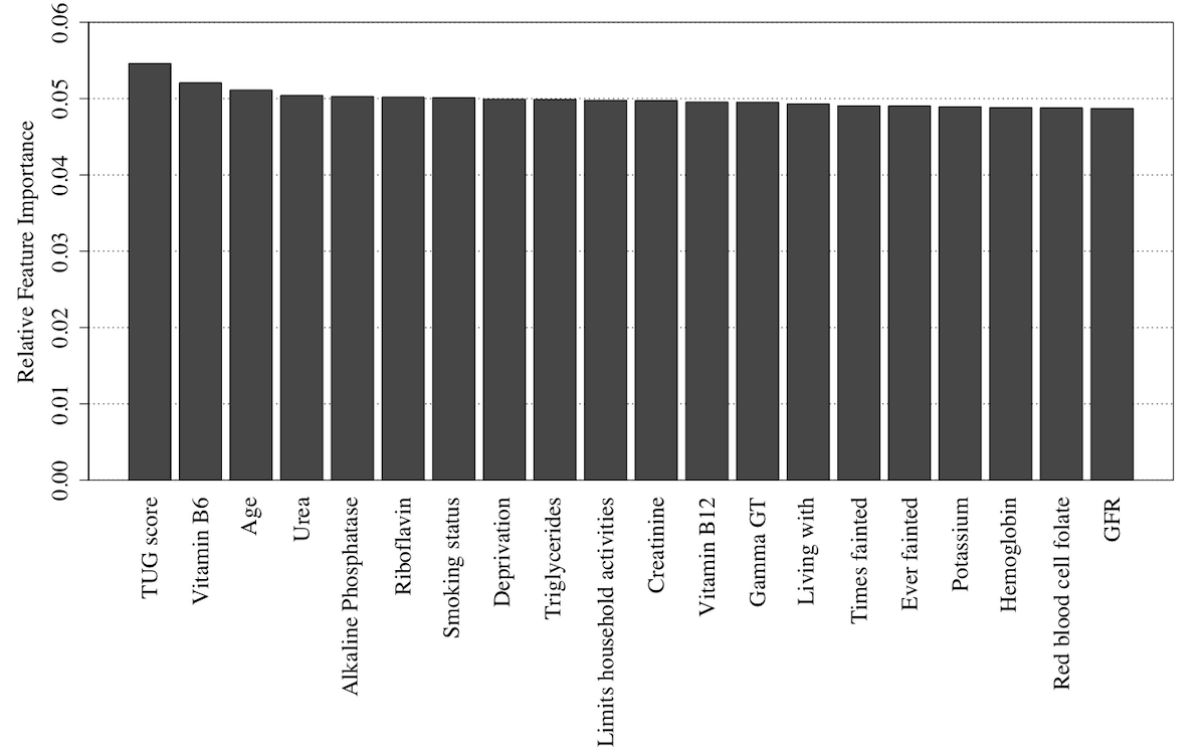
Figure 13. The 20 most important features for predicting rate of the Repeatable Battery for the Assessment of Neuropsychological Status change as detected using feature permutation using a Naïve Bayes classifier. Gamma GT: Gamma-glutamyl transferase; GFR: glomerular filtration rate; TUG: Timed Up and